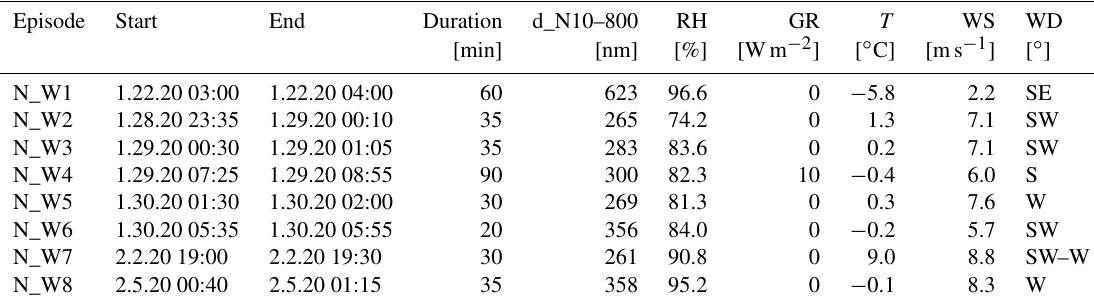
Table A3. Overview table presenting median diameter ( d ) of N10–800 calculated by fitting a log-normal function to the MPSS size dis- tributions for the selected episodes (N_W1–N_W8) along with meteorology recorded during the episodes (relative humidity – RH, global radiation – GR, temperature – T , wind speed – WS, and wind direction –